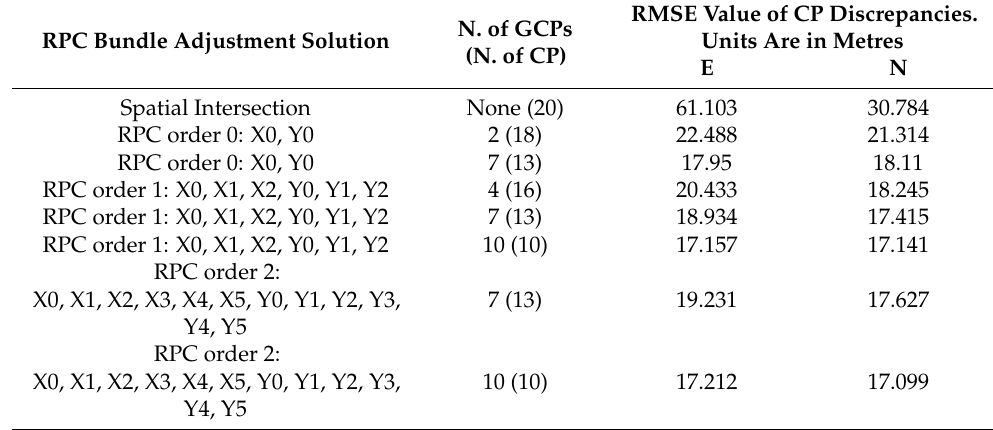
Table A4. Results of RPC bundle adjustment with bias compensation for strip in N-S direction in the right side, Rome test field.